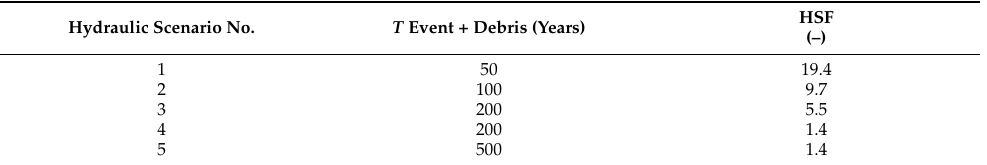
Table 5. Comparison between resistances and acting forces on each steel anchor depending on the return period T